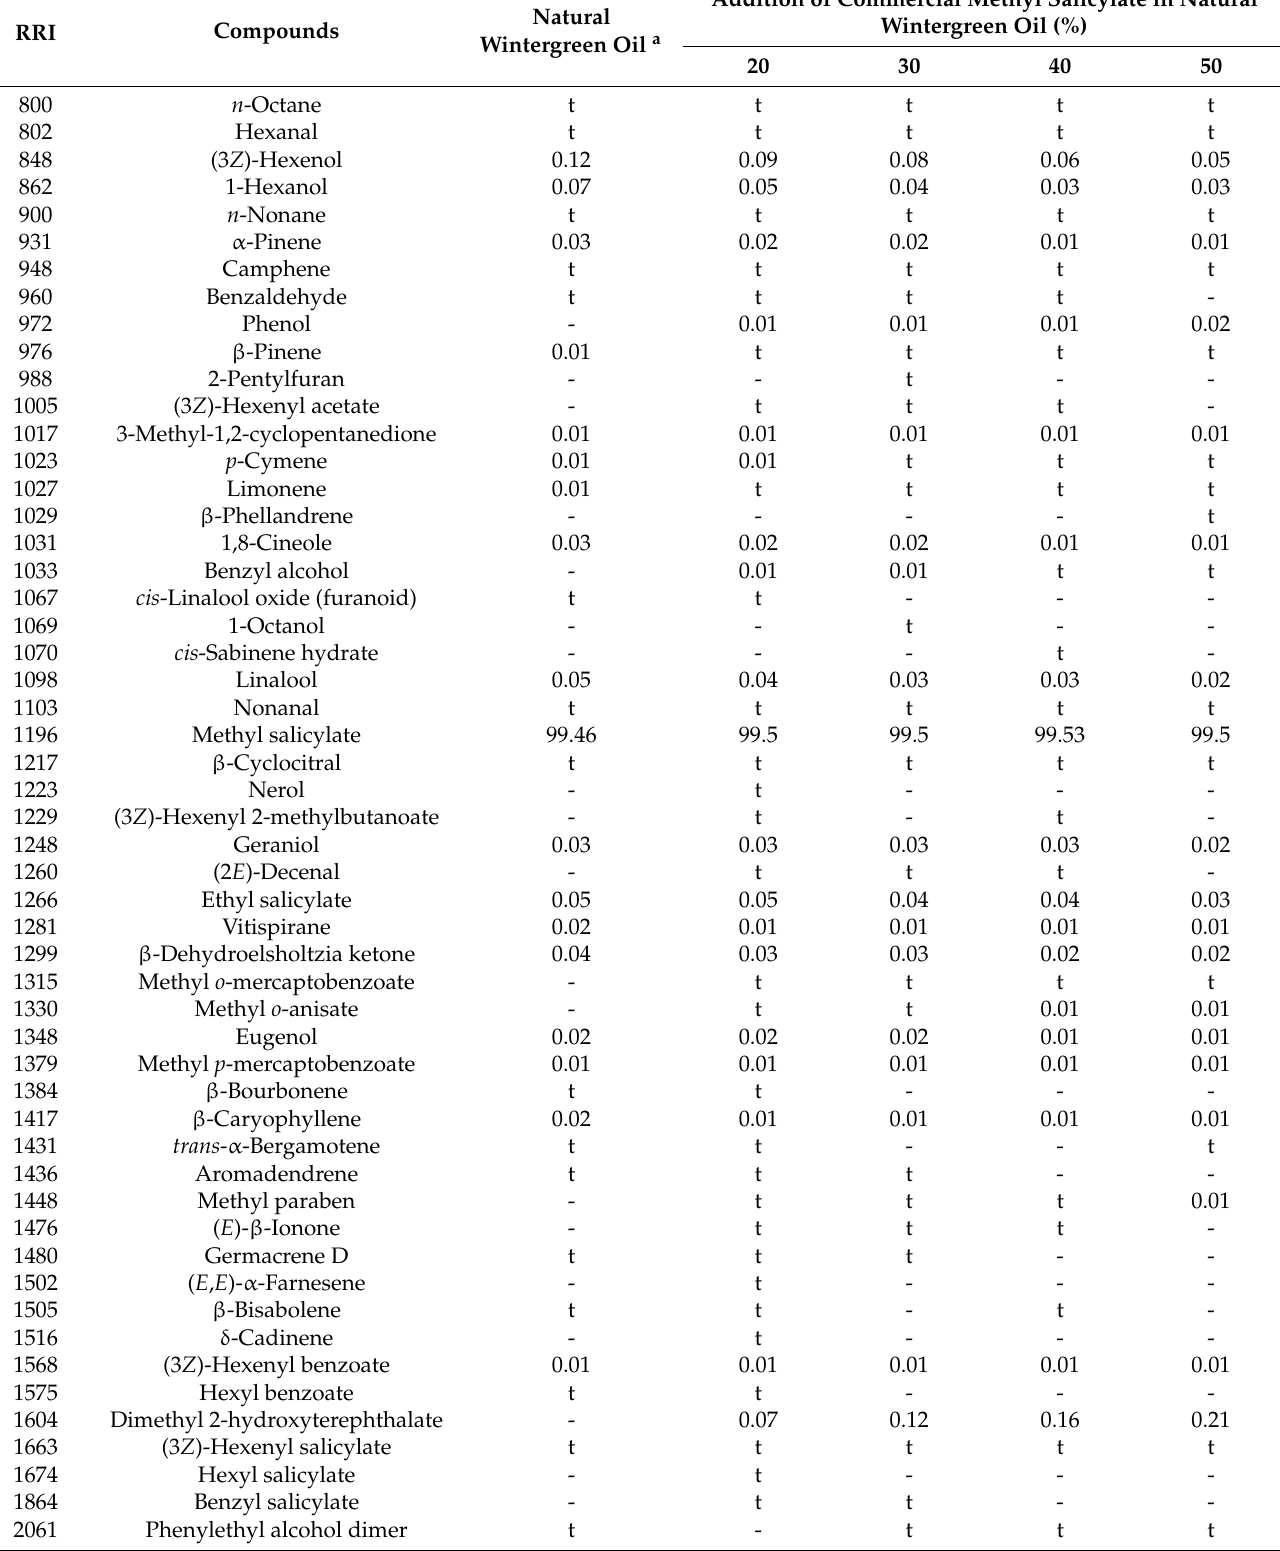
Table 7. Comparison of natural and adulterate wintergreen essential oil; “-” indicates not detected and “t” indicates trace